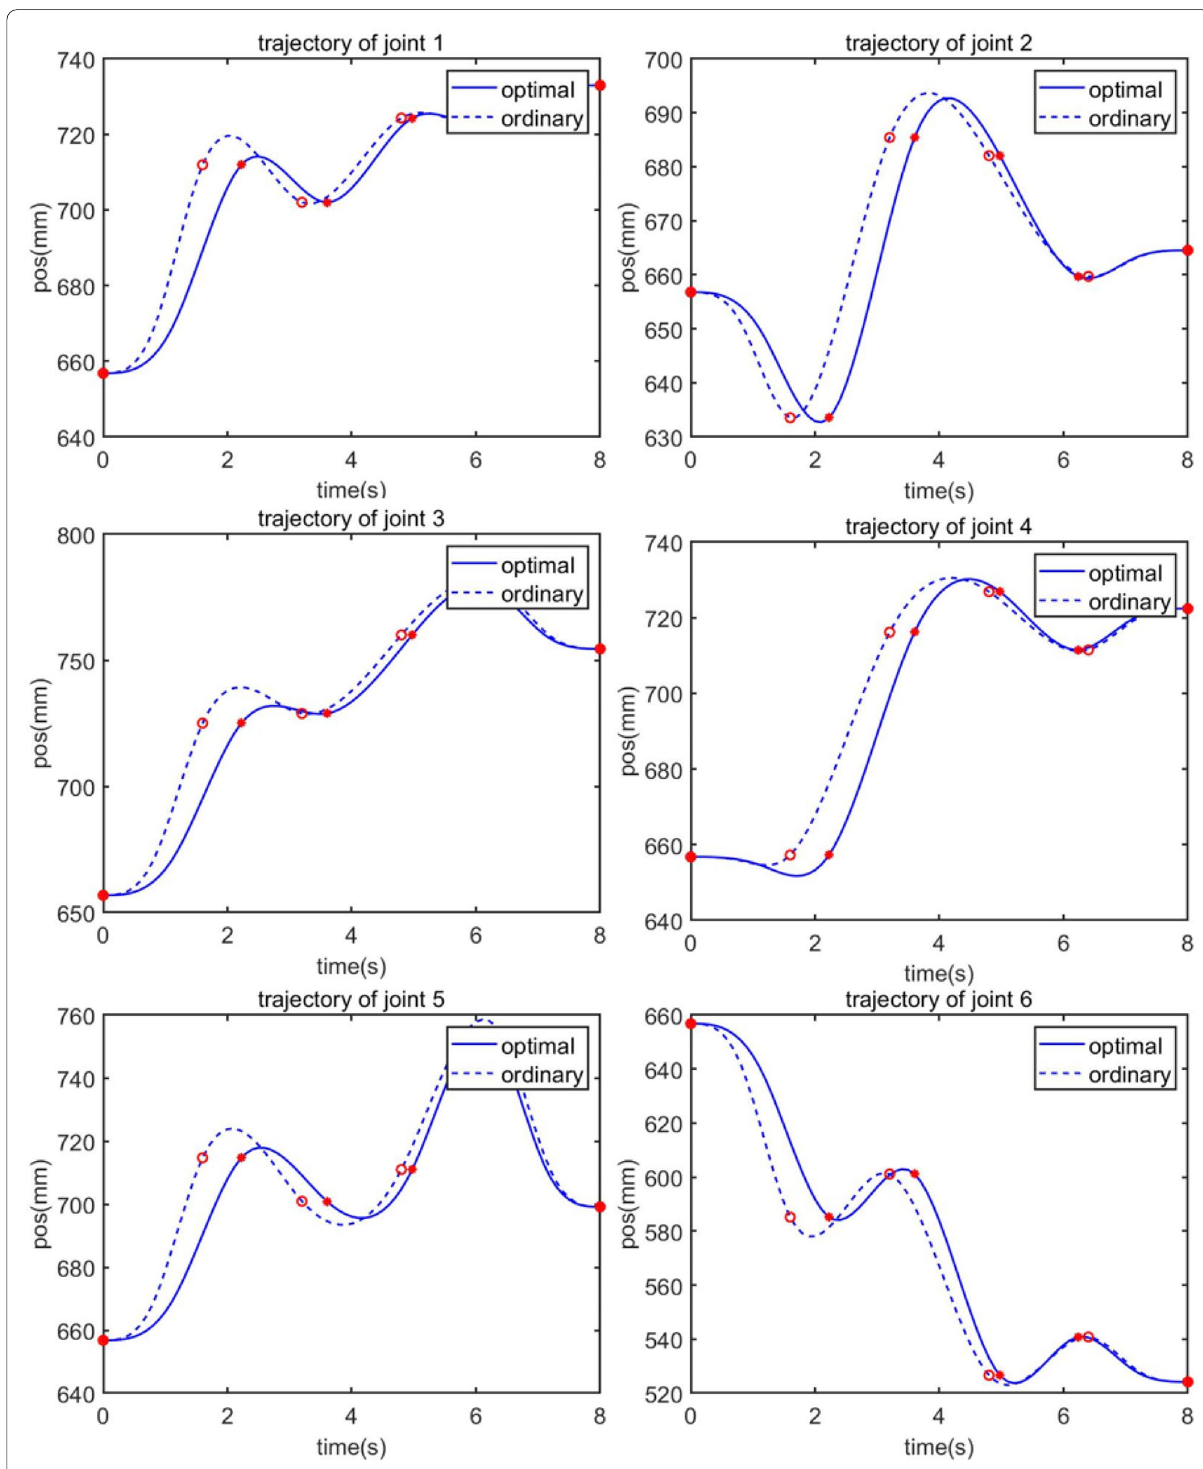
Figure 10 Trajectory of